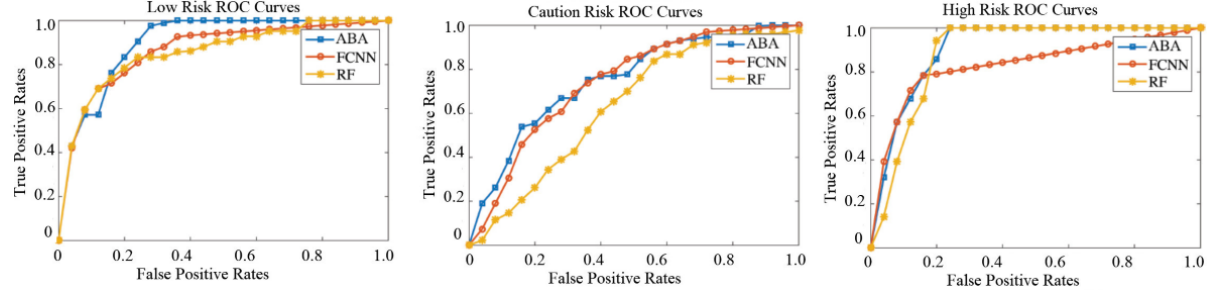
Figure 6. ROC curves of stroke risk prediction. ROC: receiver operating characteristic; ABA: abnormal blood pressure data analysis; FCNN: fully connected neural networks; RF: random